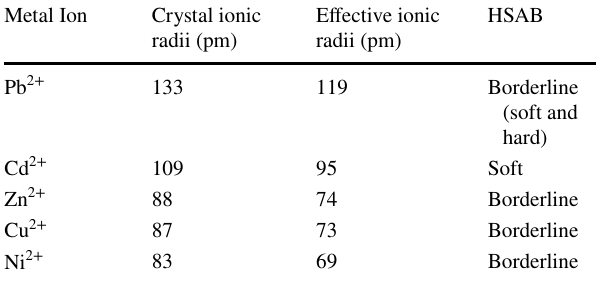
and effective ionic radii of 6-coordinate ions(Shannon 1976) and Hard and Soft, Acid and Bases (HSAB) Pearson theory of the metal ions Metal Ion Crystal ionic Effective ionic radii (pm) radii (pm)